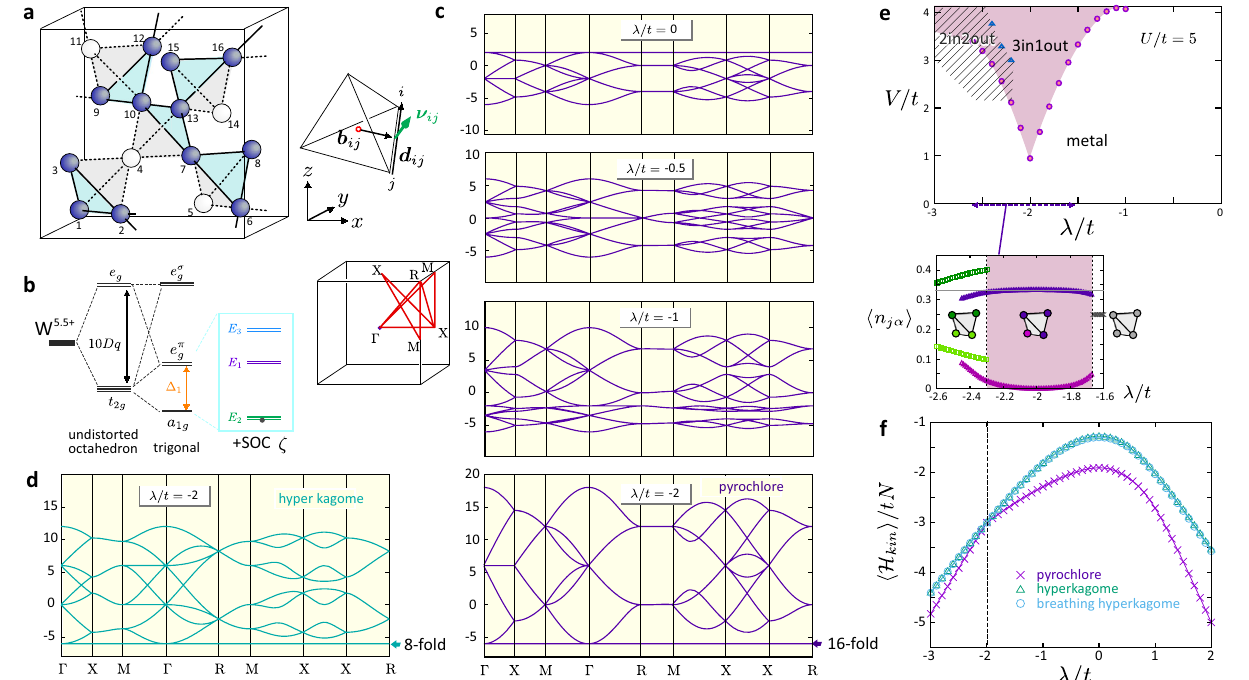
Fig. 1 Nature of energy bands and the ground state of the pyrochlore electron systems with strong SOC. a Unit cell of the pyrochlore/hyper-kagome lattice based on the W-ions, which includes four primitive pyrochlore cells. Filled and open circles represent the occupied and unoccupied sites in the trimerized charge order phase of CsW 2 O 6 , where the former forms a hyper-kagome lattice. b ij and d ij are vectors de fi ned for bond i - j , determining the form of the SOC. b Energy scheme of single W-5 d surrounded by the oxygen ligand. c Noninteracting band structure (Eq. (1) with U = V = 0) of the pyrochlore lattice for λ / t = 0, − 0.5, − 1, − 2. The k -paths are chosen as in the left side panel. d Noninteracting band structure of the hyper-kagome lattice obtained by depleting 1/4 of the lattice sites from the pyrochlore lattice with λ / t = − 2. e Mean- fi eld phase diagram of Eq. (1) on the plane of λ / t and V / t for U / t = 5. Circles/triangles represent the boundary where the energy of the 3-in-1-out becomes lower than the metallic state and 2-in-2-out state, respectively. (inset) Charge density 〈 n j ↑ 〉 = 〈 n j ↓ 〉 of charge rich and poor sites at V / t = 3 of the mean- fi eld solution. f Noninteracting band energy h H kin i of the pyrochlore, hyper-kagome, and the breathing hyper-kagome